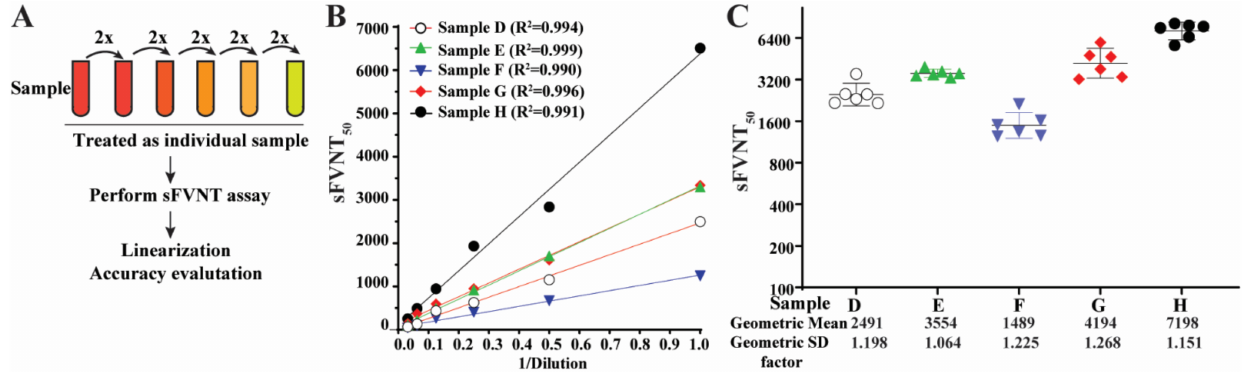
Figure 4. Linearity of the SFVNT. ( A ) The diagram of the workflow. Each neutralization-positive serum/plasma was two-fold serial diluted in a culture medium. Each dilution was treated as a sample and blinded for the SFVNT. ( B ) Person’s correlation coefficient between the dilution before the SFVNT and SFVNT 50 . p values (two-tailed) < 0.001. ( C ) The scatter-plot of the SFVNT 50 values of five serum/plasma samples calculated from all six tests. The geometric mean and geometric standard deviation (SD) factors are indicated. The error bars show the 95% confidence